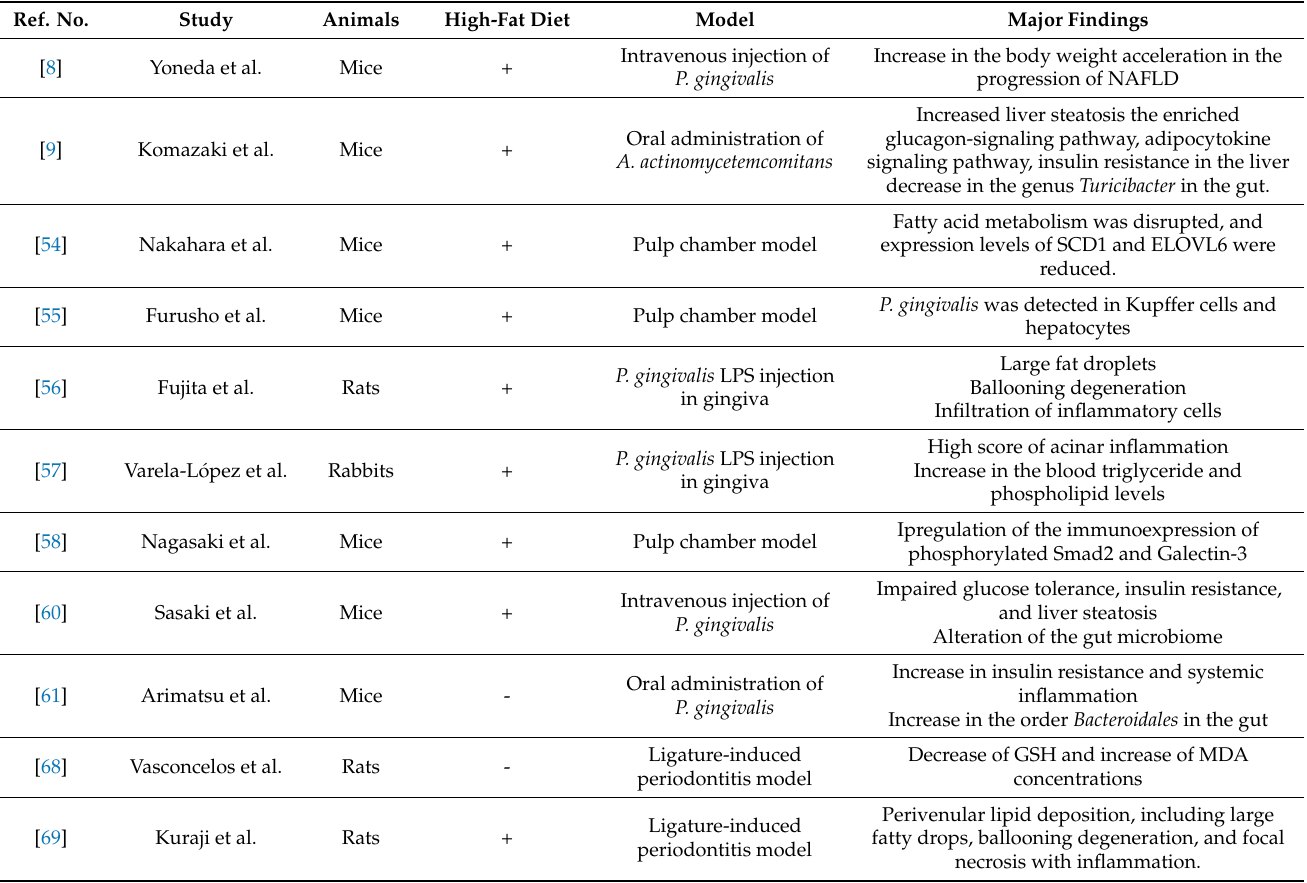
Table 5. In vivo basic research regarding the relationship between NAFLD and periodontal disease. Ref.